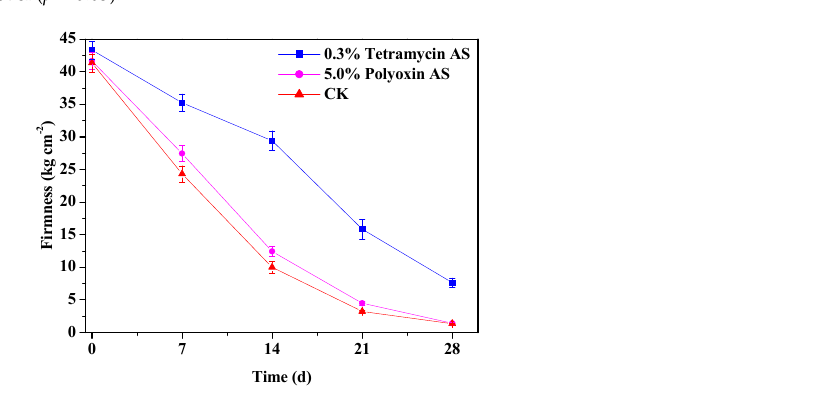
Figure 3. The effects of tetramycin and polyoxin on firmness of kiwifruit during storage. Values indicate the mean of three replicates, error bars indicate SD of three replicates.